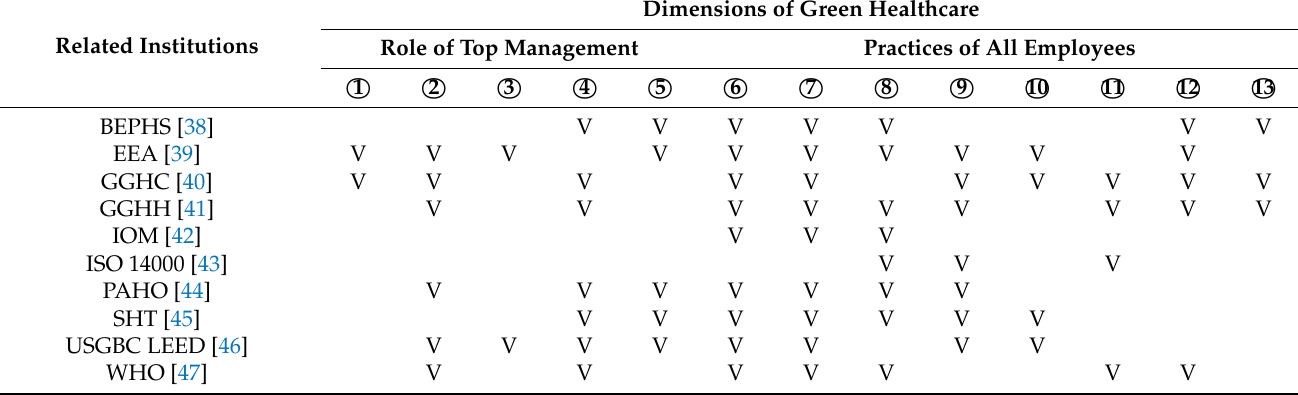
Table 1. Dimensions of green